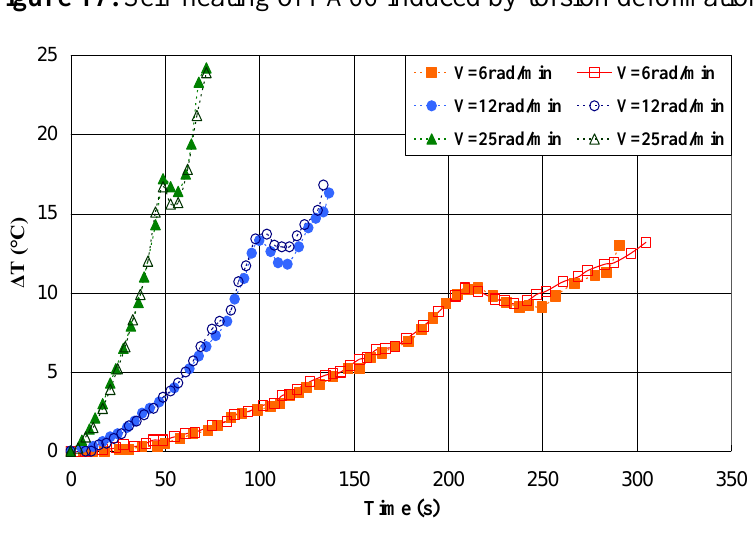
Figure 17. Self-heating of PA66 induced by torsion